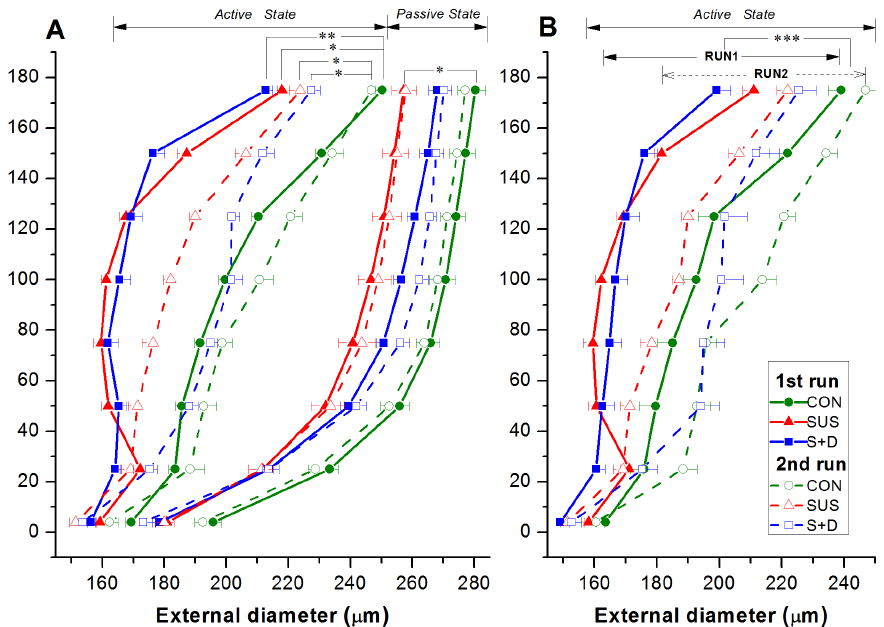
Fig. 1. (A) Pressure-external diameter relationship of middle cerebral arteries isolated from control (CON), 4-wk suspended (SUS), and 23-h/day suspended + 1-h/day standing (S + D) rats in active and passive states within the intraluminal pressure range of 4 , 175 mmHg. Two separate runs of pressure steps were performed. Data from the first and second run are represented by filled symbols connected by thick lines and open symbols by dashed lines, respectively. Values are means 6 SE. Active state: 1st run, n =13 per group; 2nd run, n =8 , 10 per group. Passive state: n =13 per group for both runs. * P , 0.05, ** P , 0.01 (2-way ANOVA). (B) Evaluation of the difference in active pressure-external diameter relationship between the 1st and 2nd run using a three-way ANOVA. n =8 , 10 per group. P , 0.001, F=32.9, df=1,